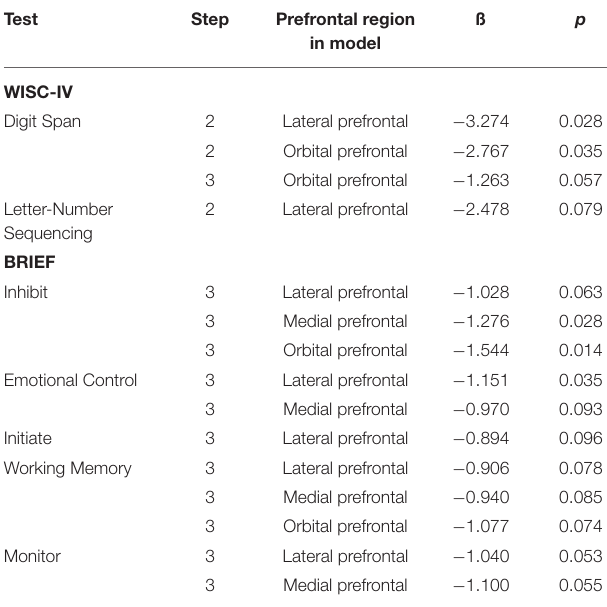
TABLE 4 | Correlations of cerebellar and prefrontal regions with executive functioning.